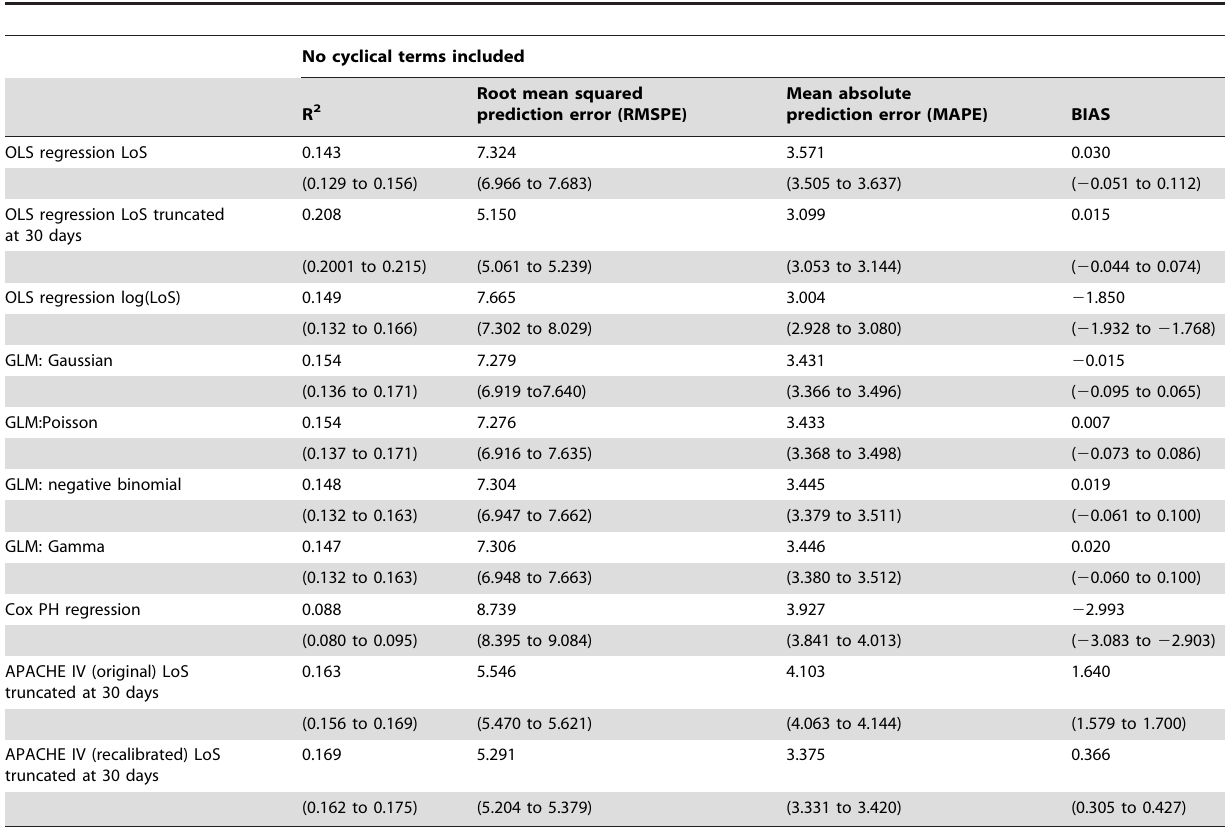
Table 2. Estimated performance of regression models, when using all patients for model construction and model validation, but no cyclical